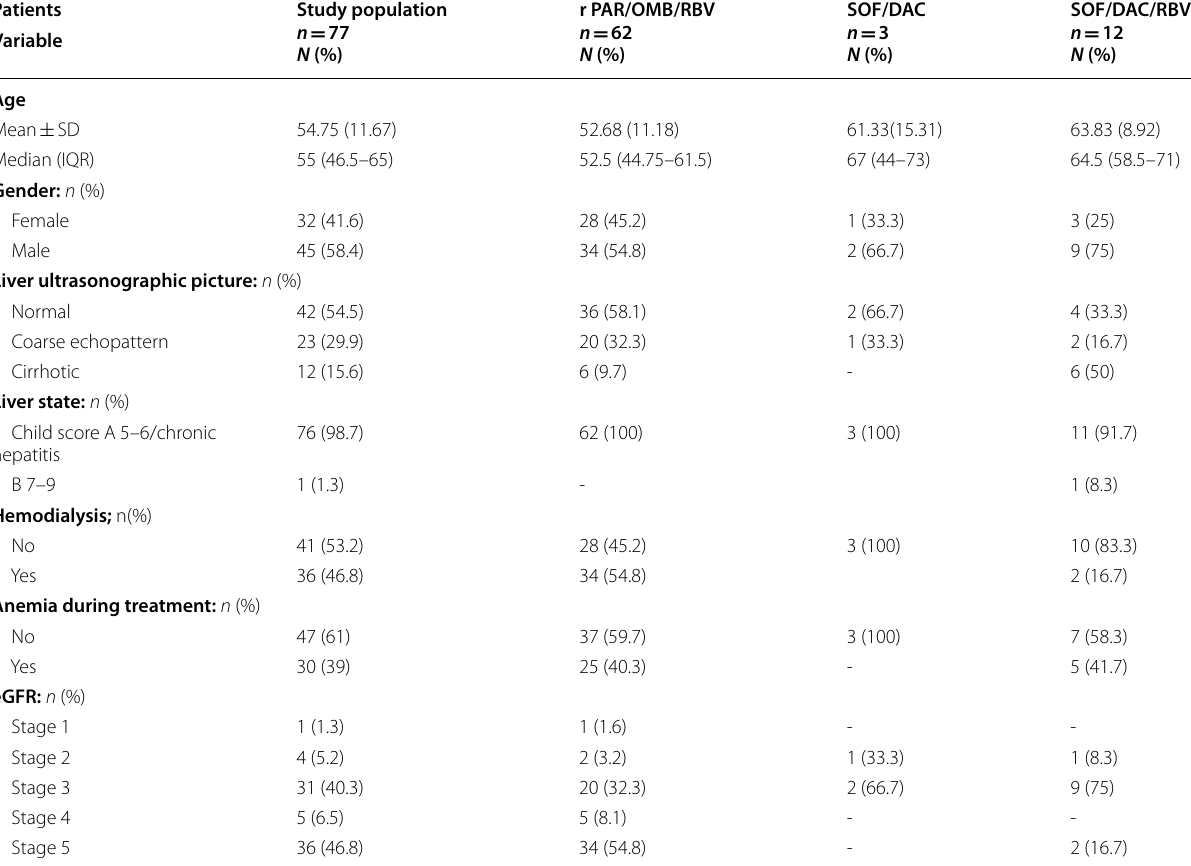
r PAR/OMB/RBV ritonavir-boosted paritaprivir, ombitasvir, and ribavirin, SOF/DAC Sofosbuvir and daclatasvir, SOF/DAC/RBV Sofosbuvir, daclatasvir, and ribavirin, eGFR Estimated glomerular filtration rate